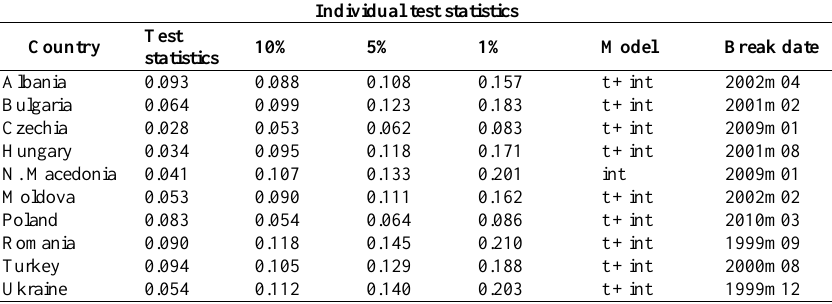
Table 4. Hadri and Rao tests for panel stationarity of real interest rate